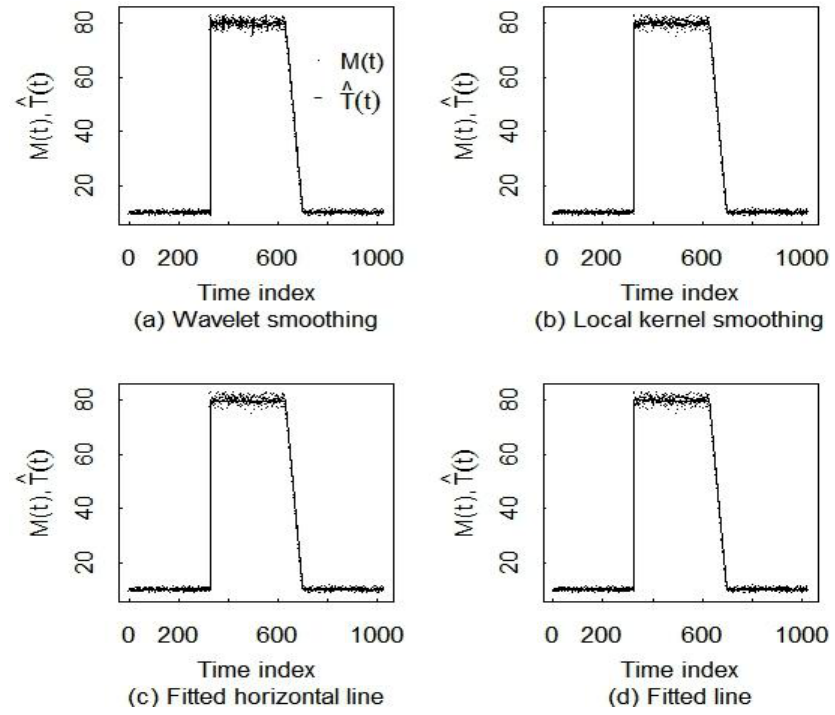
Figure 4. Four smoothing methods on simulated data.